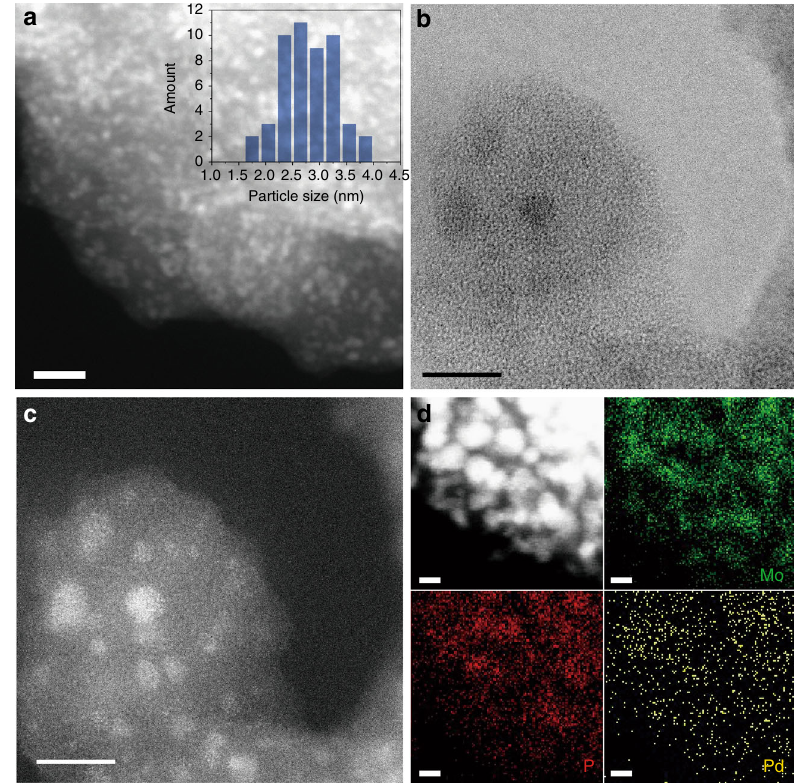
Fig. 1 Characterizations of the Pd/m – MoO 3 – P 2 O 5 /SiO 2 catalyst. a HAADF-STEM image of Pd/m – MoO 3 – P 2 O 5 /SiO 2 . Inset shows the size distribution of the nanoparticles. Scale bar equals 20 nm. b Aberration-corrected ABF scanning transmission electron microscope image and c corresponding HAADF- STEM image of Pd/m – MoO 3 – P 2 O 5 /SiO 2 . Scale bars equal 5 nm. d STEM-EDS elemental mapping results for Pd/m – MoO 3 – P 2 O 5 /SiO 2 , showing a homogeneous distribution of Mo and P elements within nanoparticles and highly dispersed Pd. Scale bar equals 3